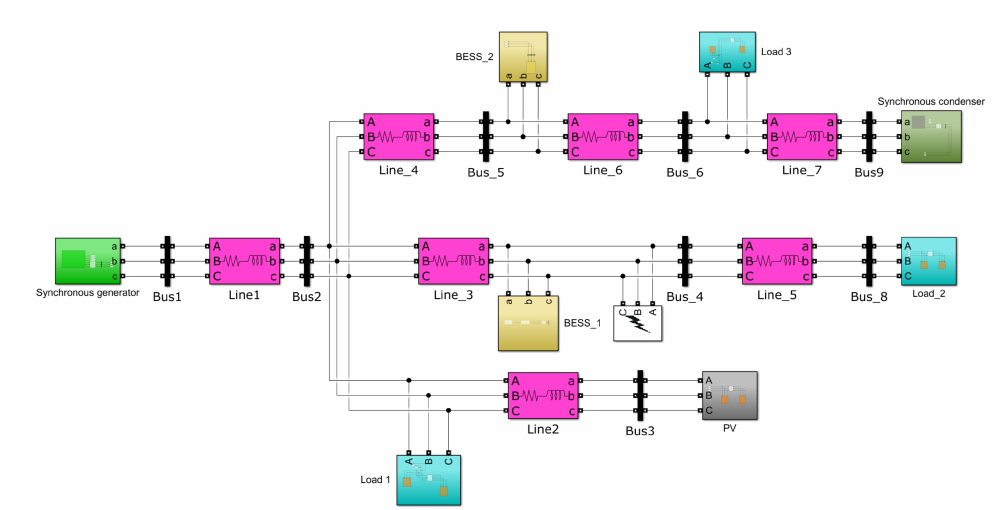
Figure 2. Single line diagram of the studied MG.